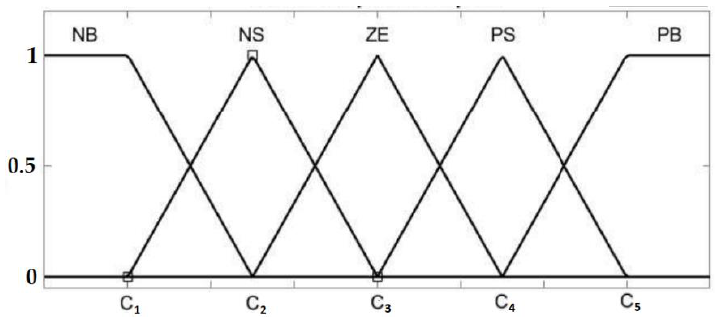
Figure 6. Fuzzy control membership functions for change in generator power error.